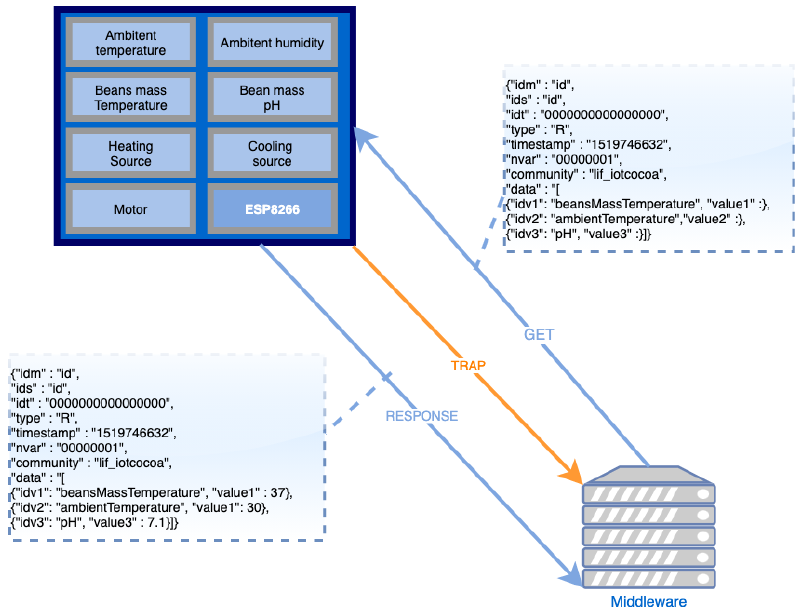
Figure 3. SNMP messages exchanged between the Middleware and Hardware